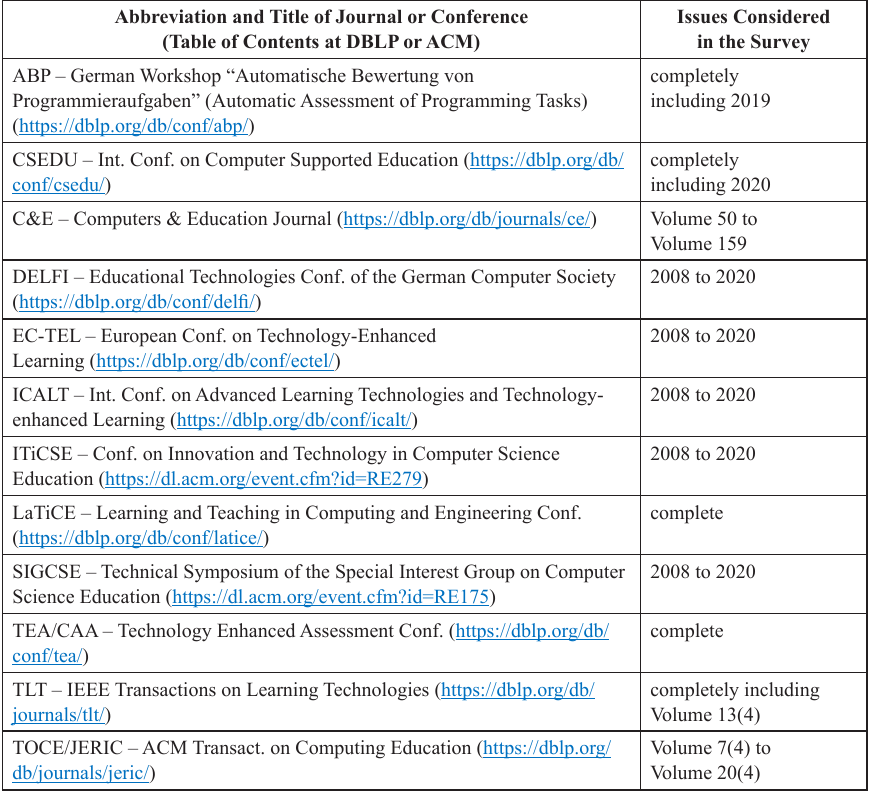
Table 2. Publication venues included in the first round of the literature survey